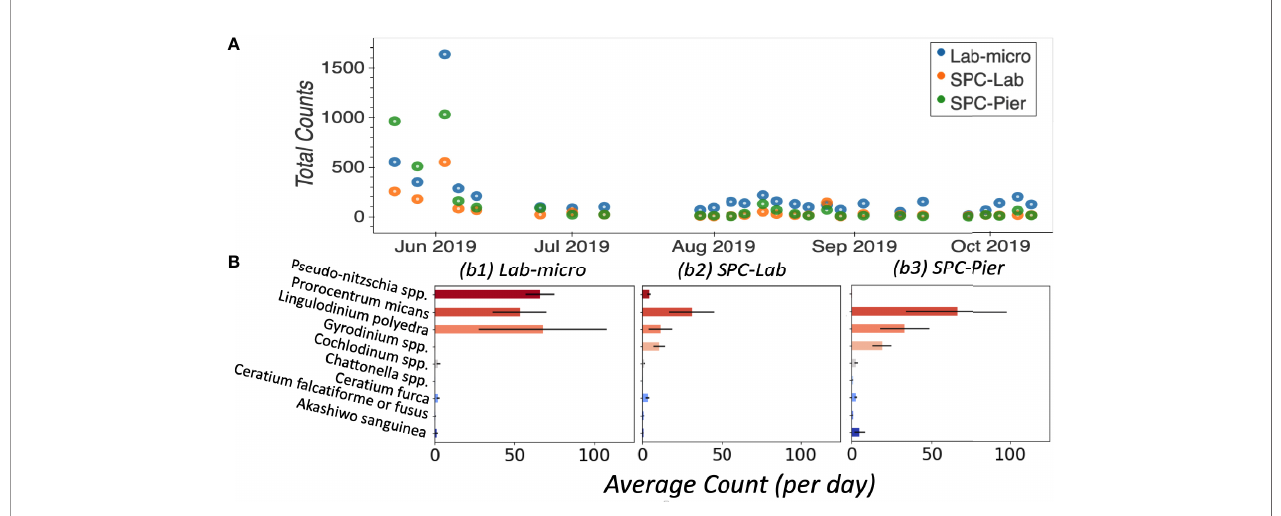
FIGURE 4 | Enumerated plankton taxa. (A) Time series of total counts as obtained by traditional methods (LAB-micro) and manual image classi fi cation of lab samples (SPC-Lab) and in situ (SPC-Pier). (B) Average count per day per species collected by each